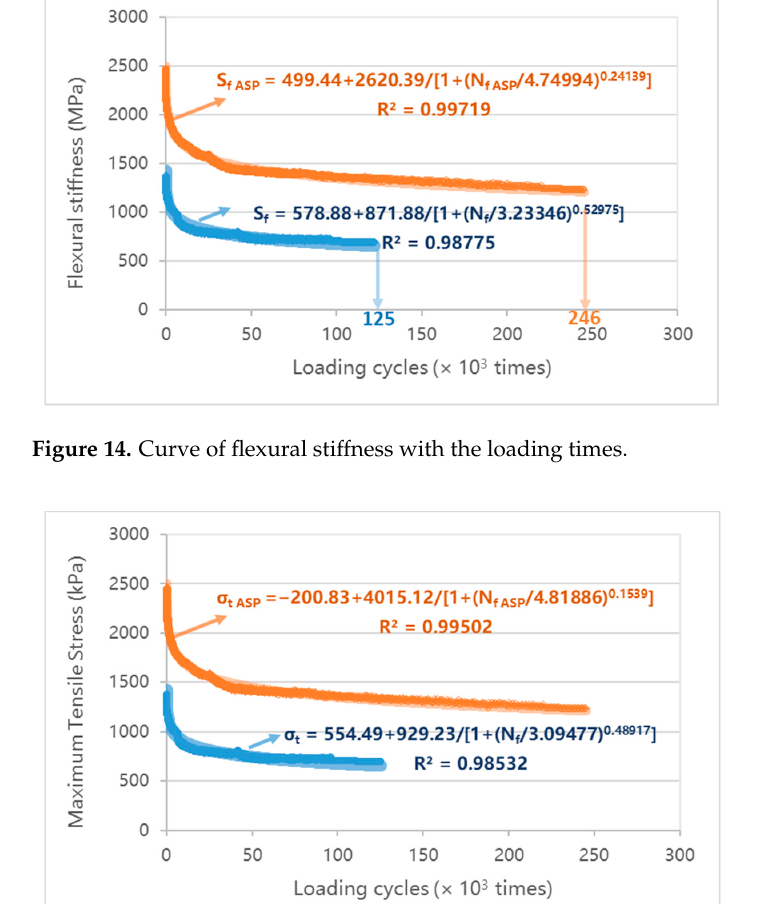
Figure 15. Curve of maximum tensile stress with the loading times.